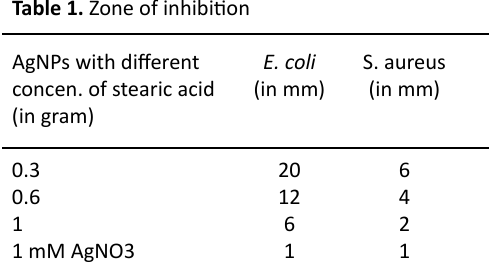
Table 1. Zone of inhibition AgNPs with different E. coli